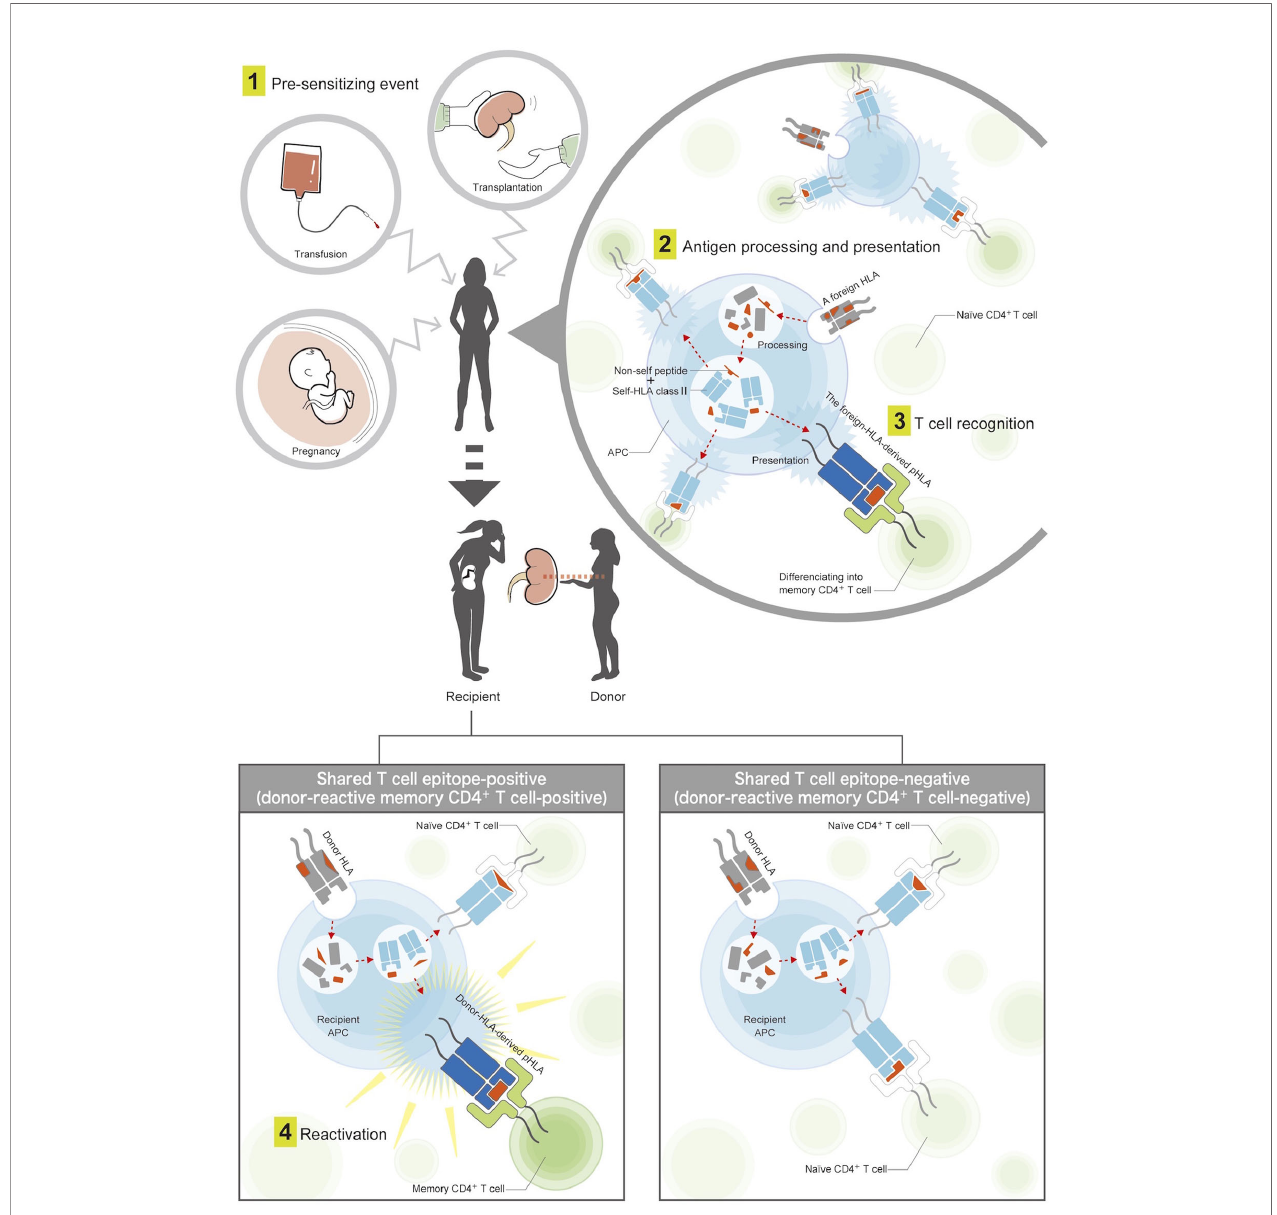
FIGURE 1 | Mechanisms of pre-sensitization via the indirect T cell-allorecognition pathway. (1) A patient is fi rst exposed to foreign HLAs by pre-sensitizing events, such as blood transfusion, pregnancy, or prior organ transplantation. (2) The foreign HLAs are processed into smaller peptides by the patient ’ s antigen-presenting cells. Among them, non-self peptides are loaded onto the recipient HLA class II, and the antigens are presented on the cell surface. (3) Patient ’ s naïve CD4 + T-helper cells recognize T cell epitopes consisting of the foreign-HLA-derived peptide in the context of recipient HLA class II (pHLA), which allows naive CD4 + T-helper cells to differentiate into memory cells. (4) These memory CD4 + T cells lead to an enhanced rapid response after second encounters with the same pHLAs derived from the donor HLA. The donor-reactive memory CD4 + T-helper cells were considered to be positive if the foreign-HLA-derived pHLAs were shared with donor-HLA-derived pHLAs, and negative if not